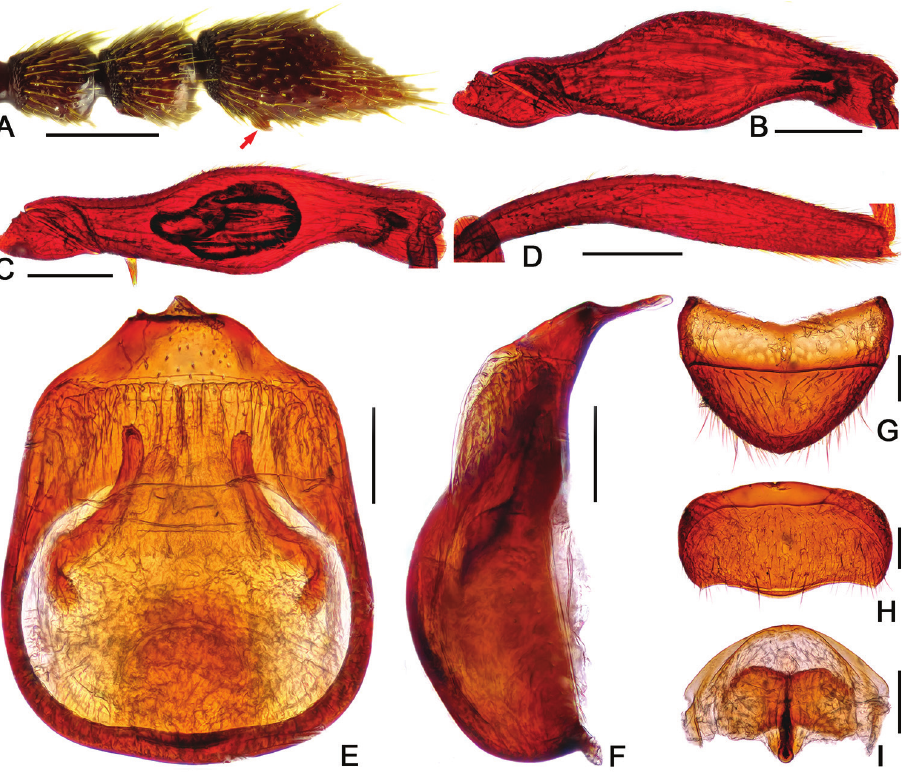
Figure 6. Diagnostic features of Batrisodes simianshanus ( A–F Male G–I Female). A Antennal club (ar- row indicates ventral denticle). B Protrochanter and profemur C Mesotrochanter and mesofemur D Mes- otibia E–F Aedeagus, in ventral ( E ), and lateral ( F ) views ( G ) Tergite VIII ( H ) Sternite VIII ( I ) Genital complex. Scale bars: 0.2 mm ( A–D ); 0.1 mm ( E–I